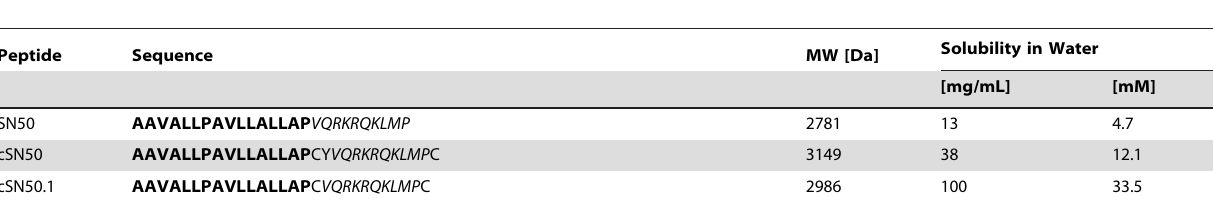
Table 1. Amino acid sequence of cSN50.1 peptide and its congeners SN50 and cSN50.